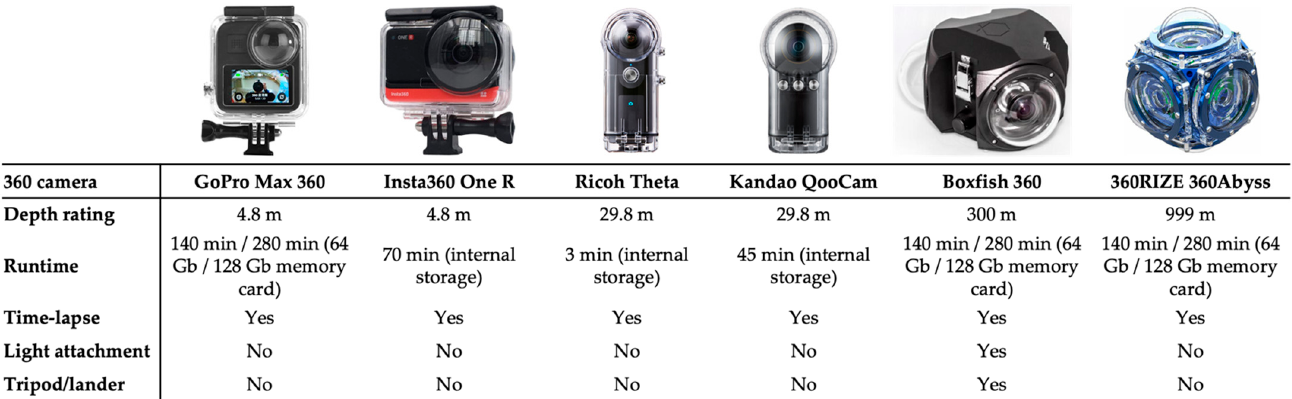
Figure 1. The six 360-degree cameras initially considered (from left to right): GoPro Max 360, In- sta360 One R, Ricoh Theta, Kandao QooCam, Boxfish 360, and 360RIZE